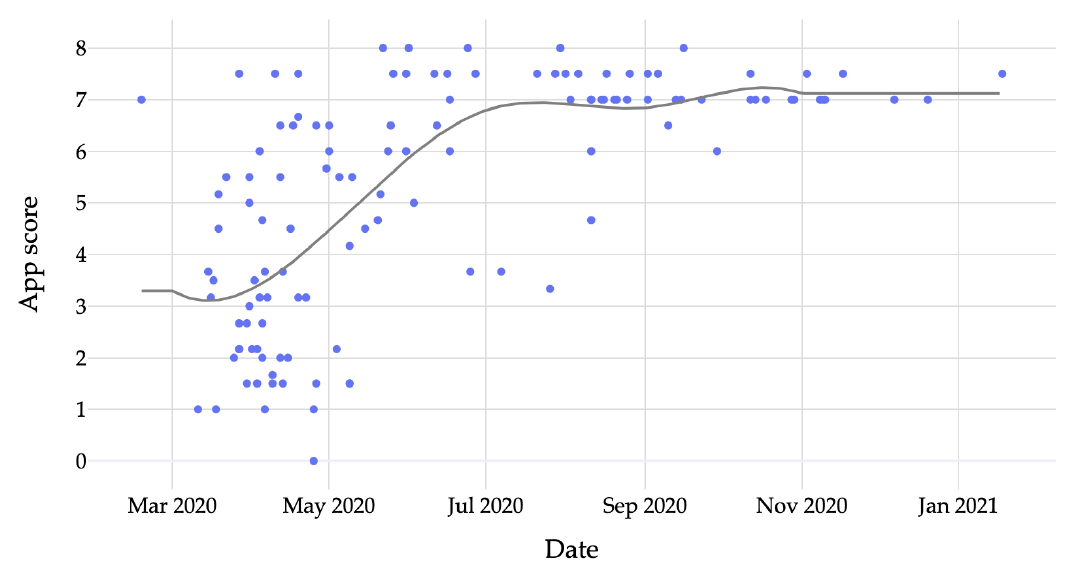
Figure 7. Ethical alignment scores of applications as a function of release date. The grey line indicates a B-spline with knots every other month from March to November